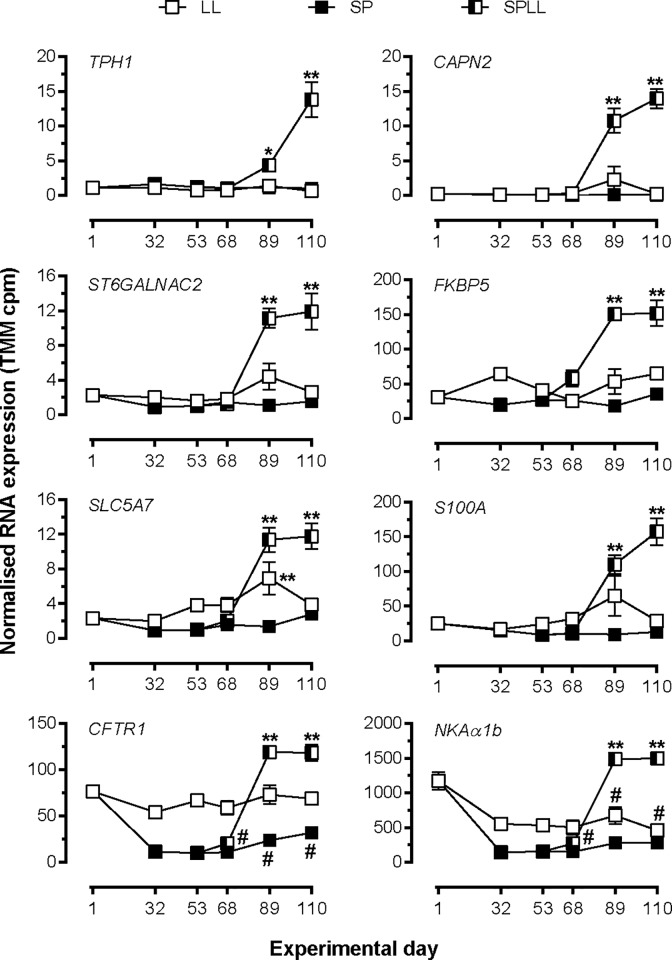
Temporal expression profiling of selected genes from cluster 3 in experiment 1.Data are presented as normalized (TMM) counts and are mean± SEM of n = 6 fish, except for SPLL on day 68 where n = 5. *, ** significantly higher expression than LL and SP values at the corresponding time point, p<0.05, 0.01, respectively; # significantly lower expression than at day 1, p<0.05. Where error bars do not appear, errors lie within the symbol.